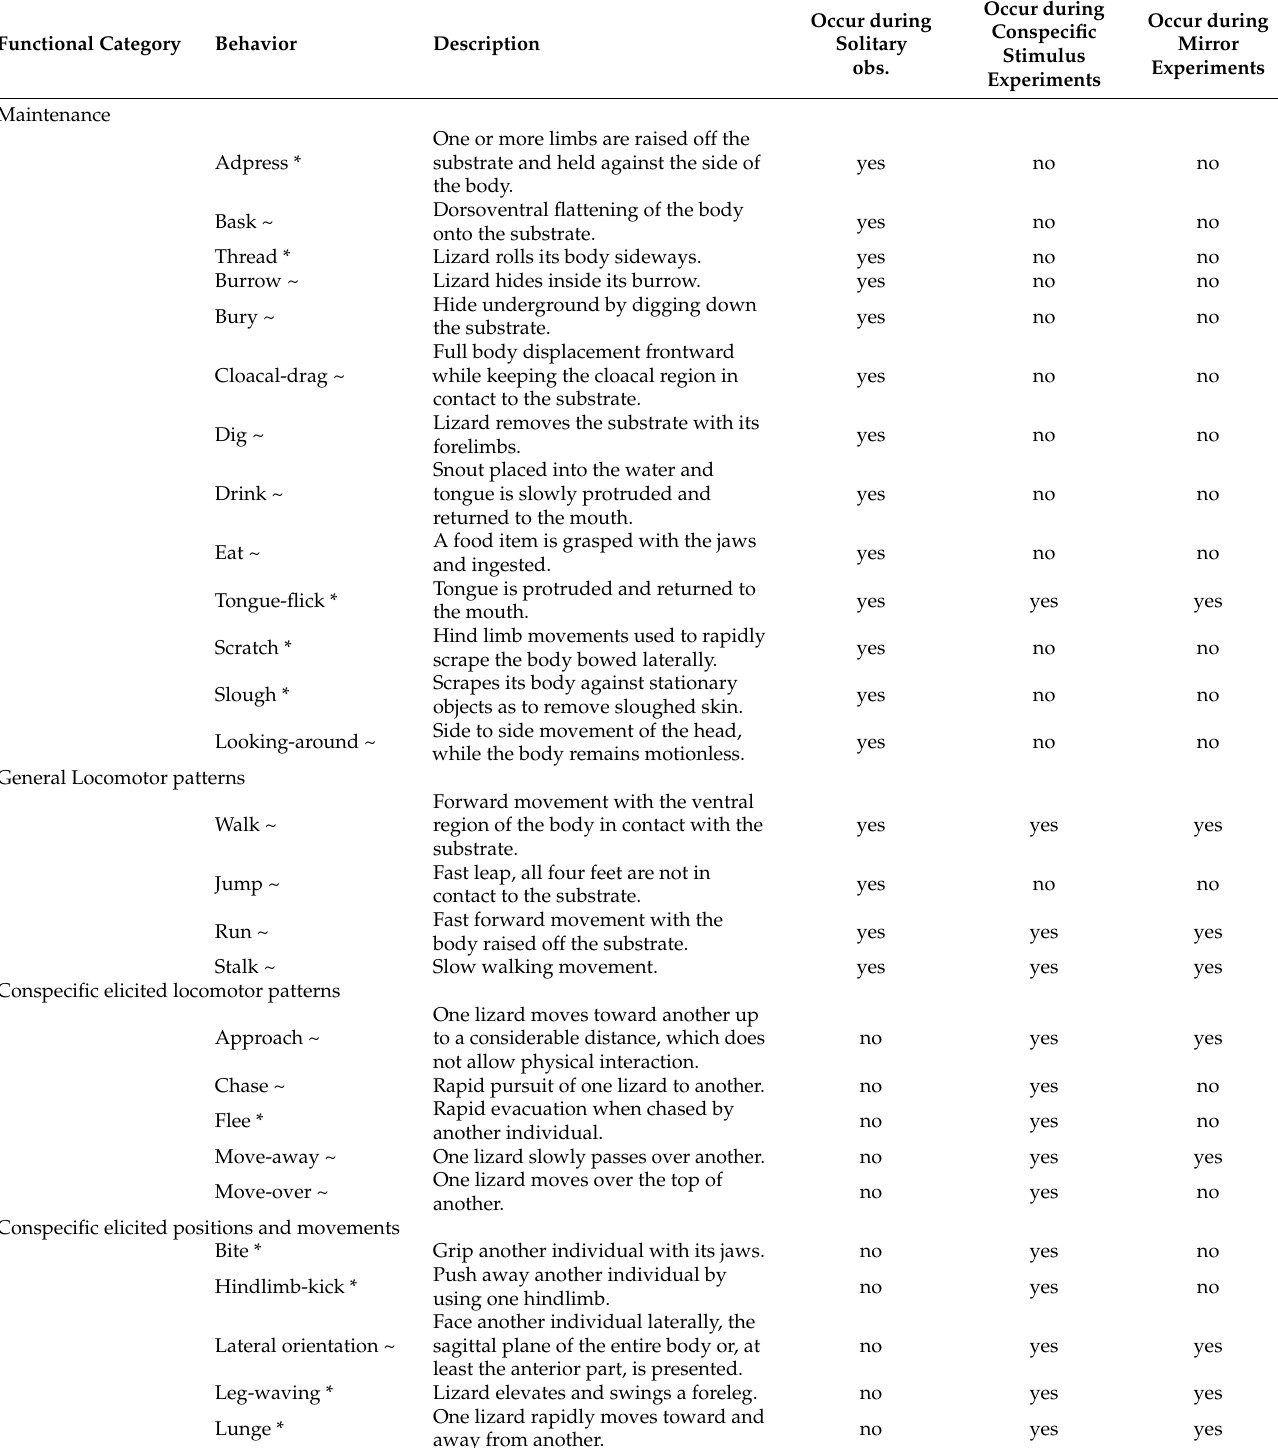
Table 1. Ethogram of Pholidobolus montium. Behaviors of individuals maintained in captivity are listed and have been assigned to functional categories based on current observations and previous studies. The symbols imply states (~) or events